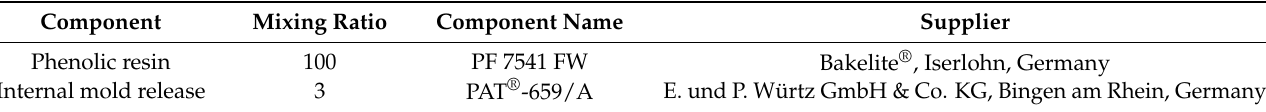
Table 1. Phenolic resin system.